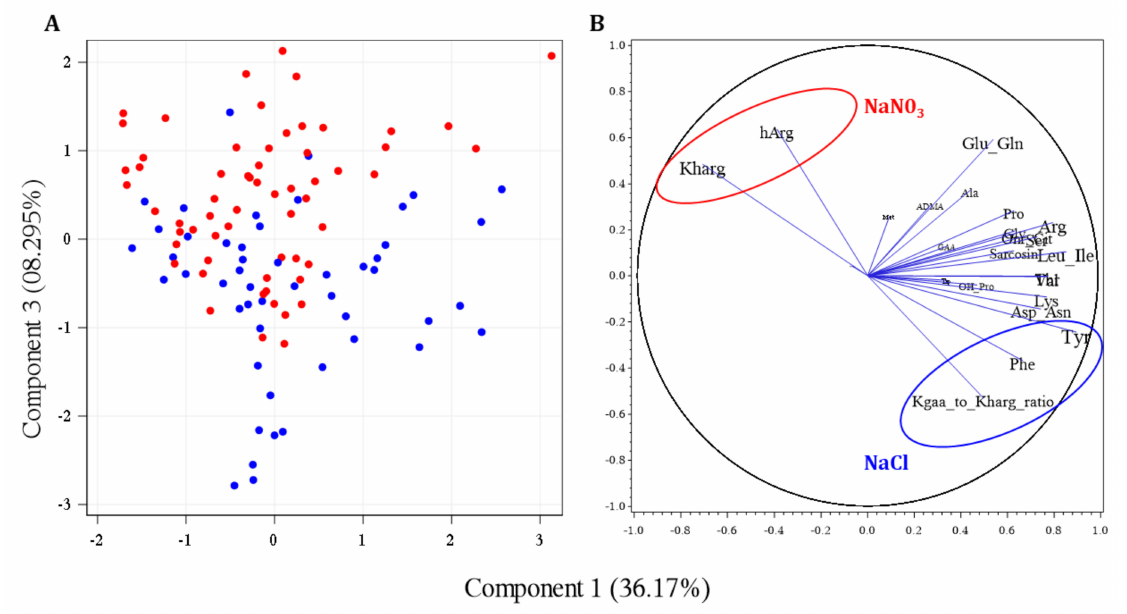
Figure 8. Score plot of observations ( A ) and variables factor map ( B ) projected onto principal component 1 and principal component